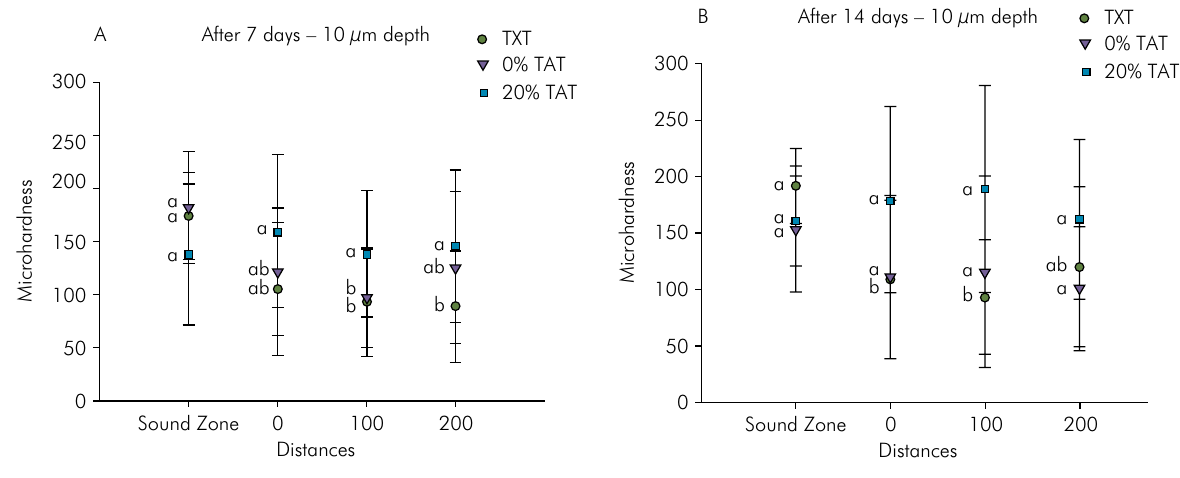
Figure 5. (A) Comparison of microhardness at 10-µm depth after 7 and 14 days among different distances within each group. No alteration was observed for 20% TAT group while a decrease was observed for TXT and 0% TAT groups at 100 and 200 µm distances. (B) No alteration was observed for 20% TAT group while a decrease was observed for TXT and 0% TAT group at 0, 100, and 200 µm.